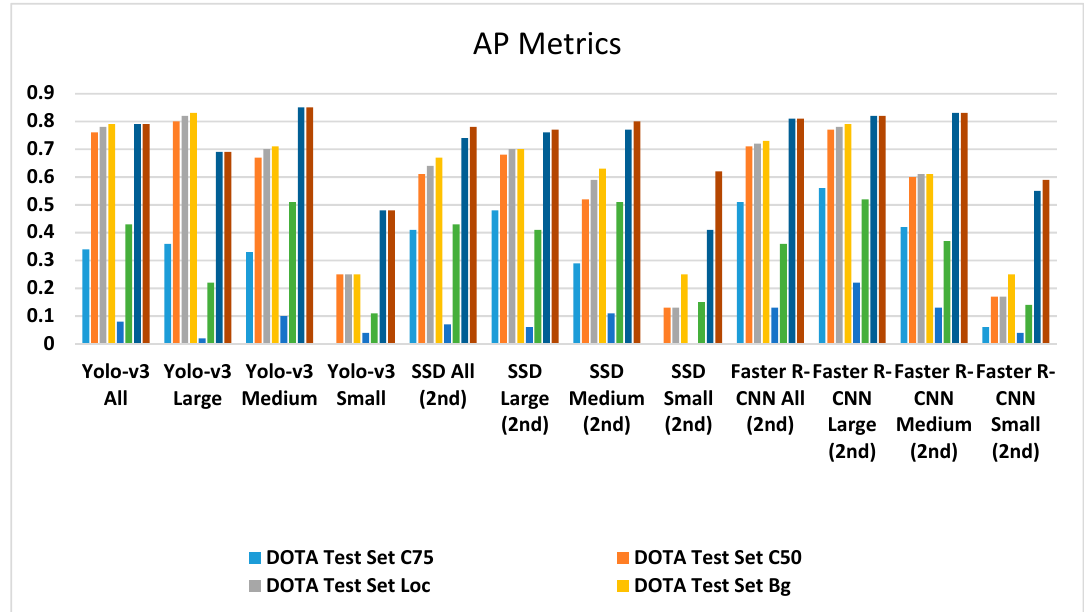
Figure 10. Graphic representation of COCO AP metric results.